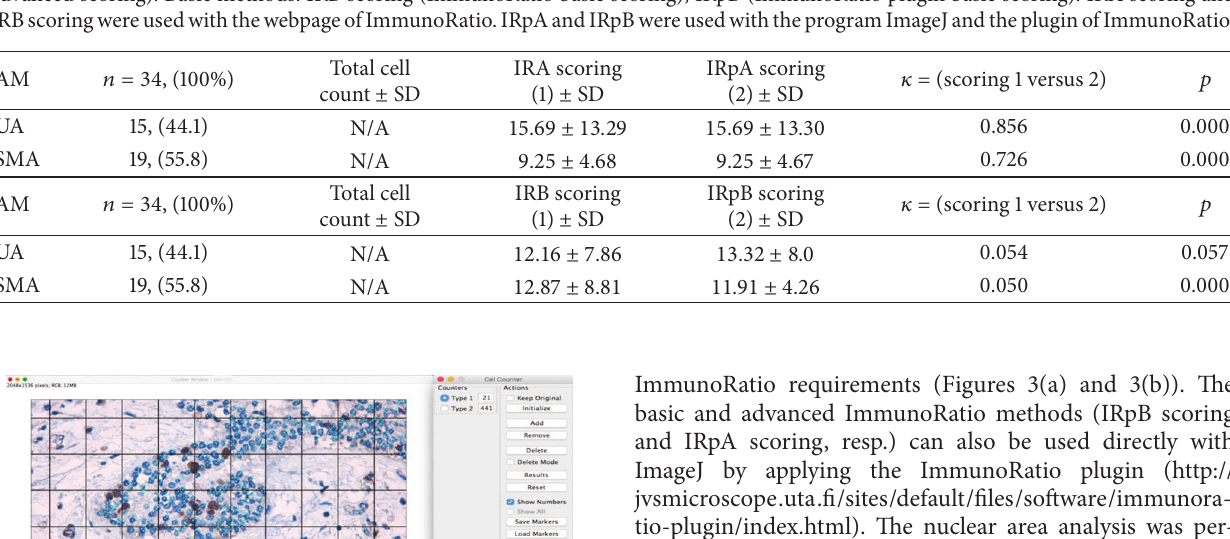
Table 2: Automatic method used to determine label index with basic and advanced ImmunoRatio. The table shows the total of tumorous cells obtained from ameloblastoma by the use of techniques of ImmunoRatio; the kappa index obtained for each range is also shown. The kappa index ranged from substantial to almost perfect for all the advanced methods of ImmunoRatio in all cases. 𝜅 = (scoring 1 versus 2) and 𝑝 = 0.000 . For the basic methods of ImmunoRatio, the Kappa index was moderate 𝜅 = (scoring 1 versus 2) and without statistical significance for the UA. The advanced methods: IRA scoring (ImmunoRatio advanced scoring) and IRpA scoring (ImmunoRatio plugin